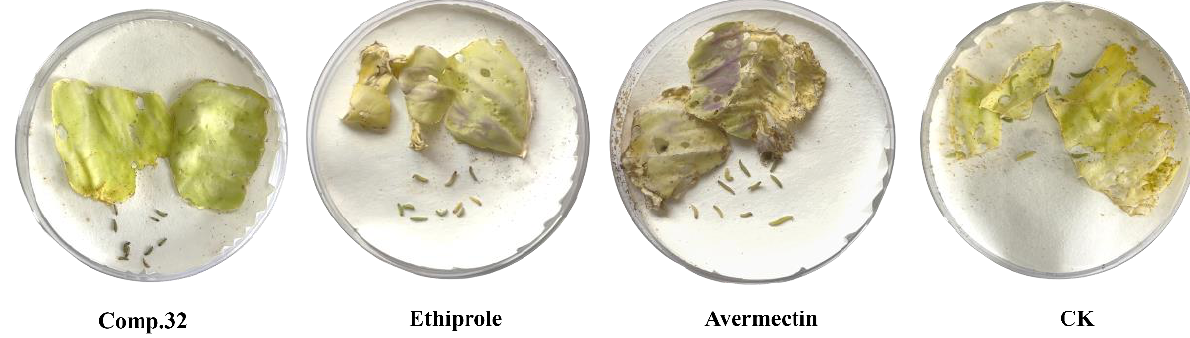
Figure 5. Insecticidal activity of the compounds against Plutella xylostella at 10 mg/L (48 h).